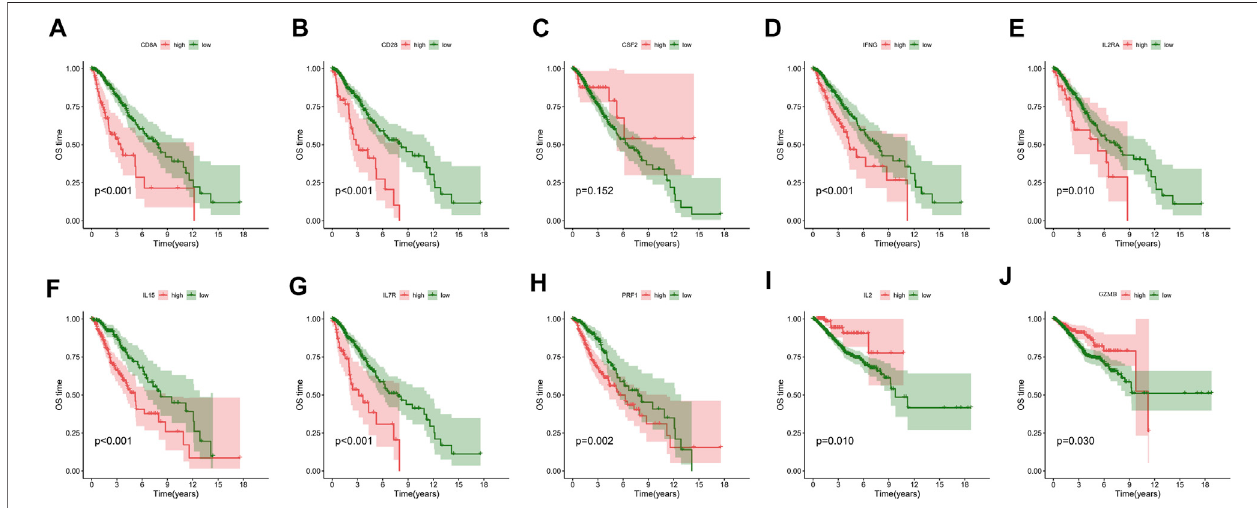
FIGURE 12 | Overall survival analysis of (A) CD8A, (B) CD28, (C) CSF2, (D) IFNG, (E) IL2RA, (F) IL15, (G) IL7R, (H) PRF1, (I) IL2, and (J)